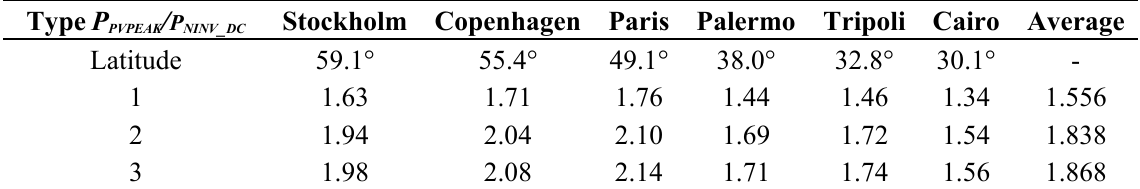
Table 4. Power ratio between P PVpeak / P nINV_DC for different solar inverters and for different